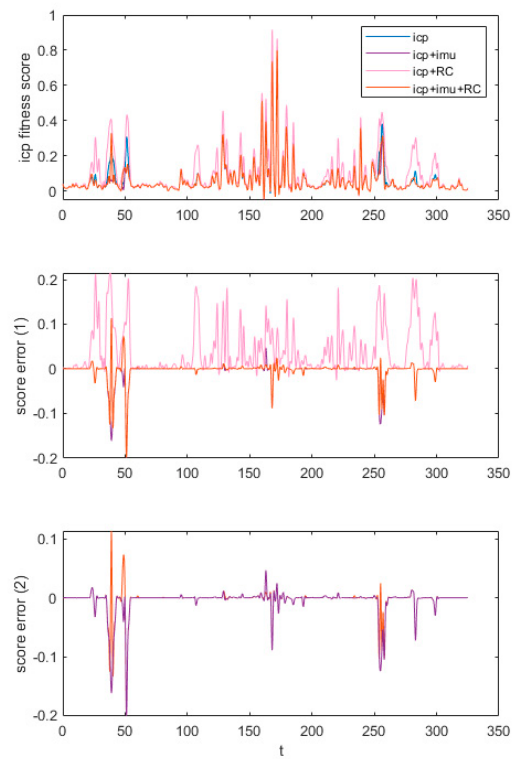
Figure 11. Comparison of different ICP registrations.